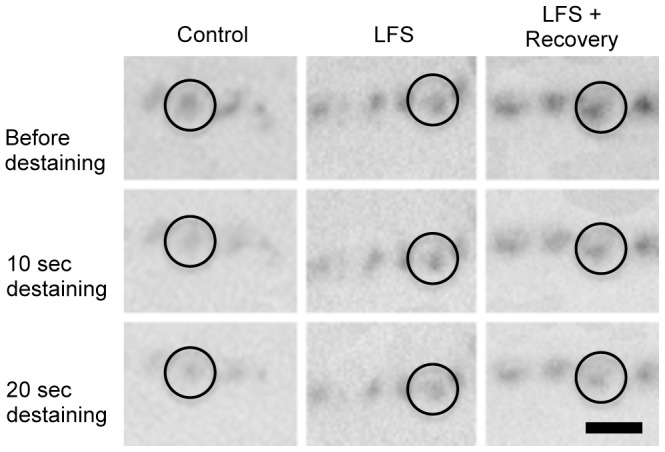
LFS is observed as a reversible reduction in vesicle exocytosis from the readily releasable pool.Puncta reflecting FM2-10 labeled readily releasable pool vesicles in motor nerve terminals before destaining (top row), after a single destaining stimulus (30 Hz stimulation for 10 sec in dye-free medium, middle row) and after two consecutive destaining stimuli (bottom row). Destaining was compared between control preparations, low-frequency stimulated (LFS) preparations, and LFS preparations that were left for two hours to recover before destaining (LFS + recovery). An individual punctum in each image is circled to assist visual comparison of destaining in the three conditions. Scale bar 5 microns.